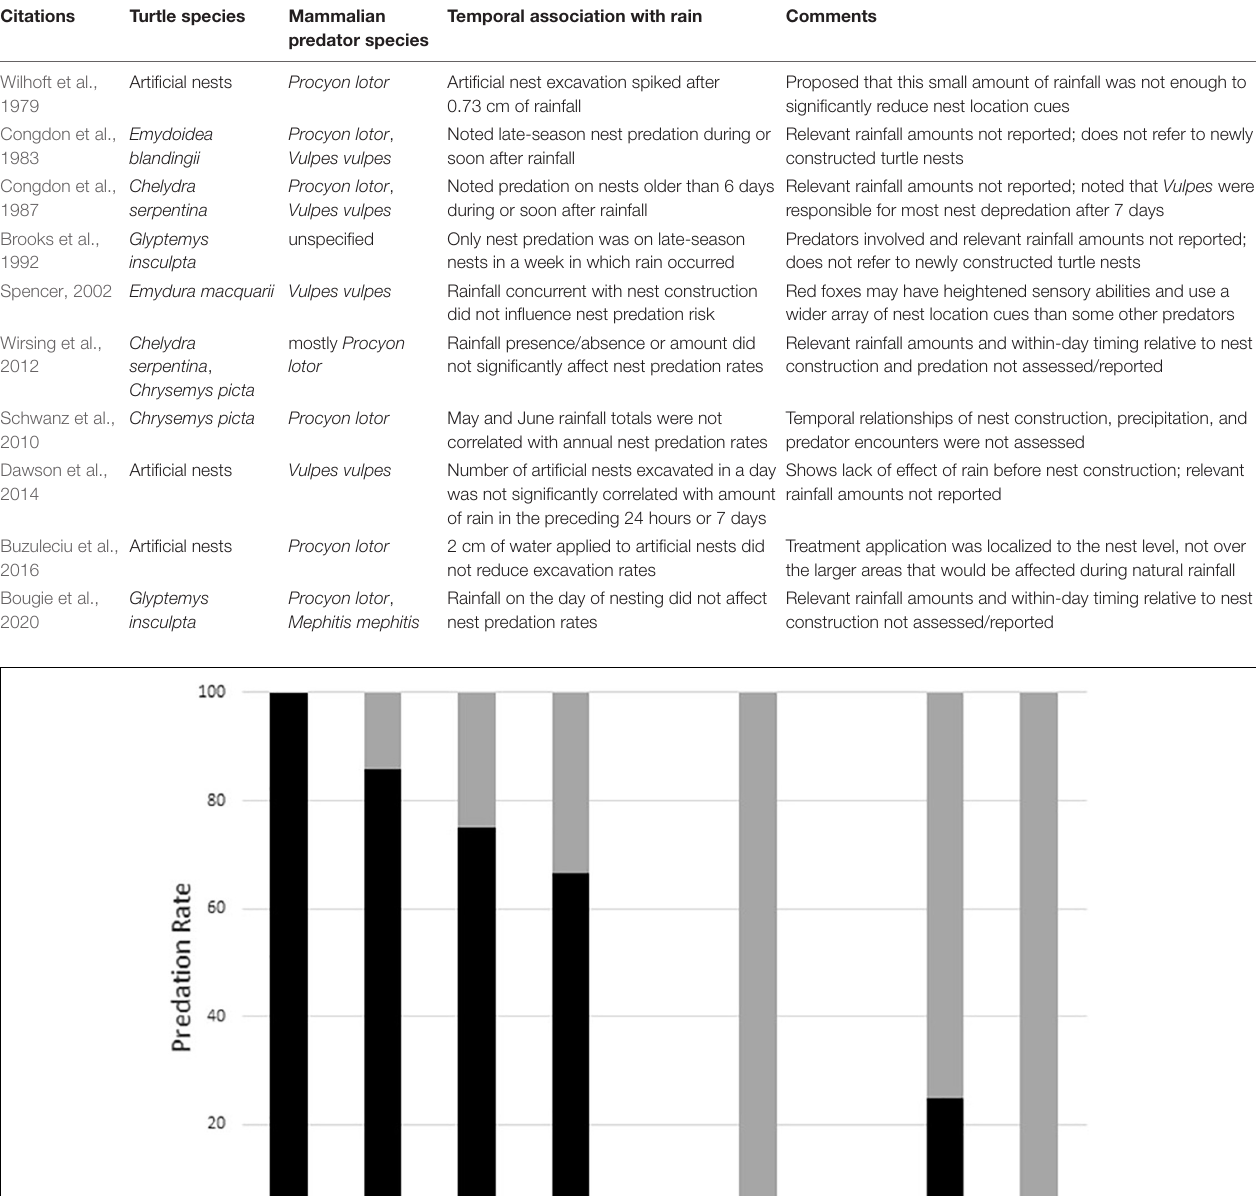
TABLE 5 | Papers suggesting freshwater turtle nest survival is not enhanced by rainfall.